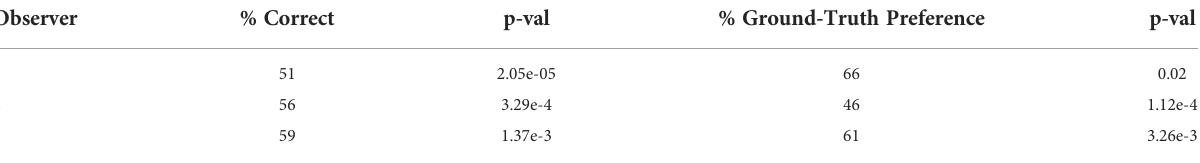
TABLE 3 Visual Turing test and image preference results for three physician expert observers.